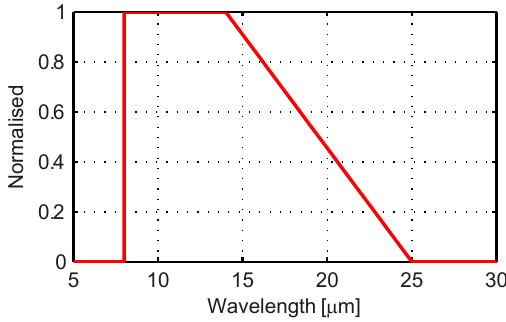
Figure 2. Response function R λ of the camera of the IRCCAM instrument.